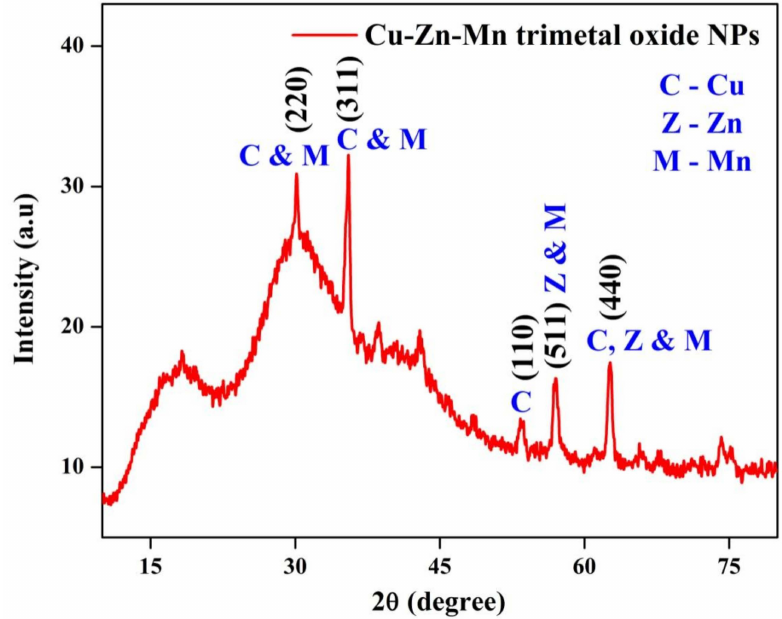
Figure 2. XRD pattern of Cu-Zn-Mn mixed trimetal oxide